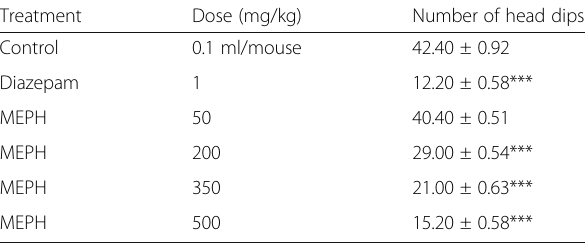
Table 8 The effect of MEPH on hole-board test in mice Treatment